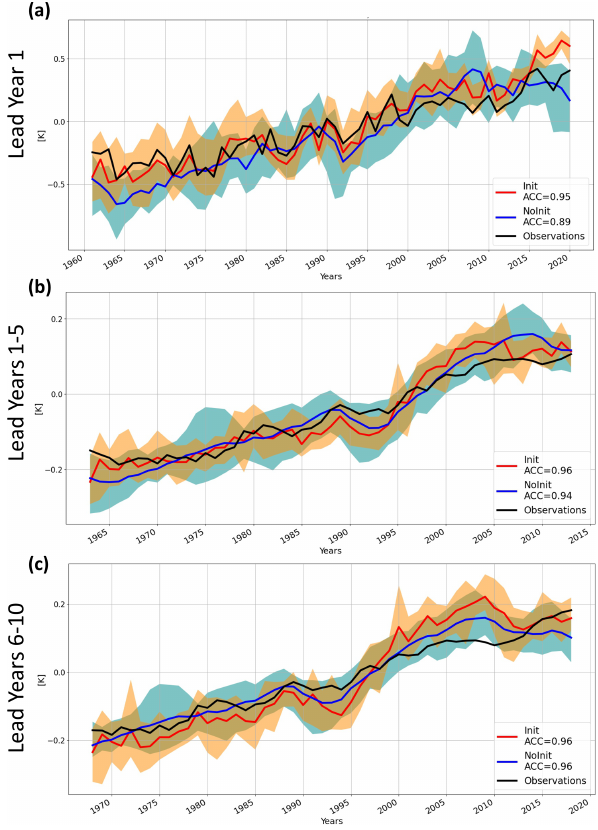
Figure 1. Global mean near-surface temperature (T2m plus SST) annual average anomaly time series (K) for the hindcast (Init; in red), historical and SSP2 scenario (NoInit, in blue), and CRU TS v4.05 and HadISST1.1 (in black), for (a) forecast years 1, (b) 1–5, and (c) 6–10. The orange (cyan)-colored envelope denotes the intra- ensemble spread for Init (NoInit). The time series are centered at the lead year interval, e.g., 1963 corresponds to the 1961–1965 mean in panel (b)